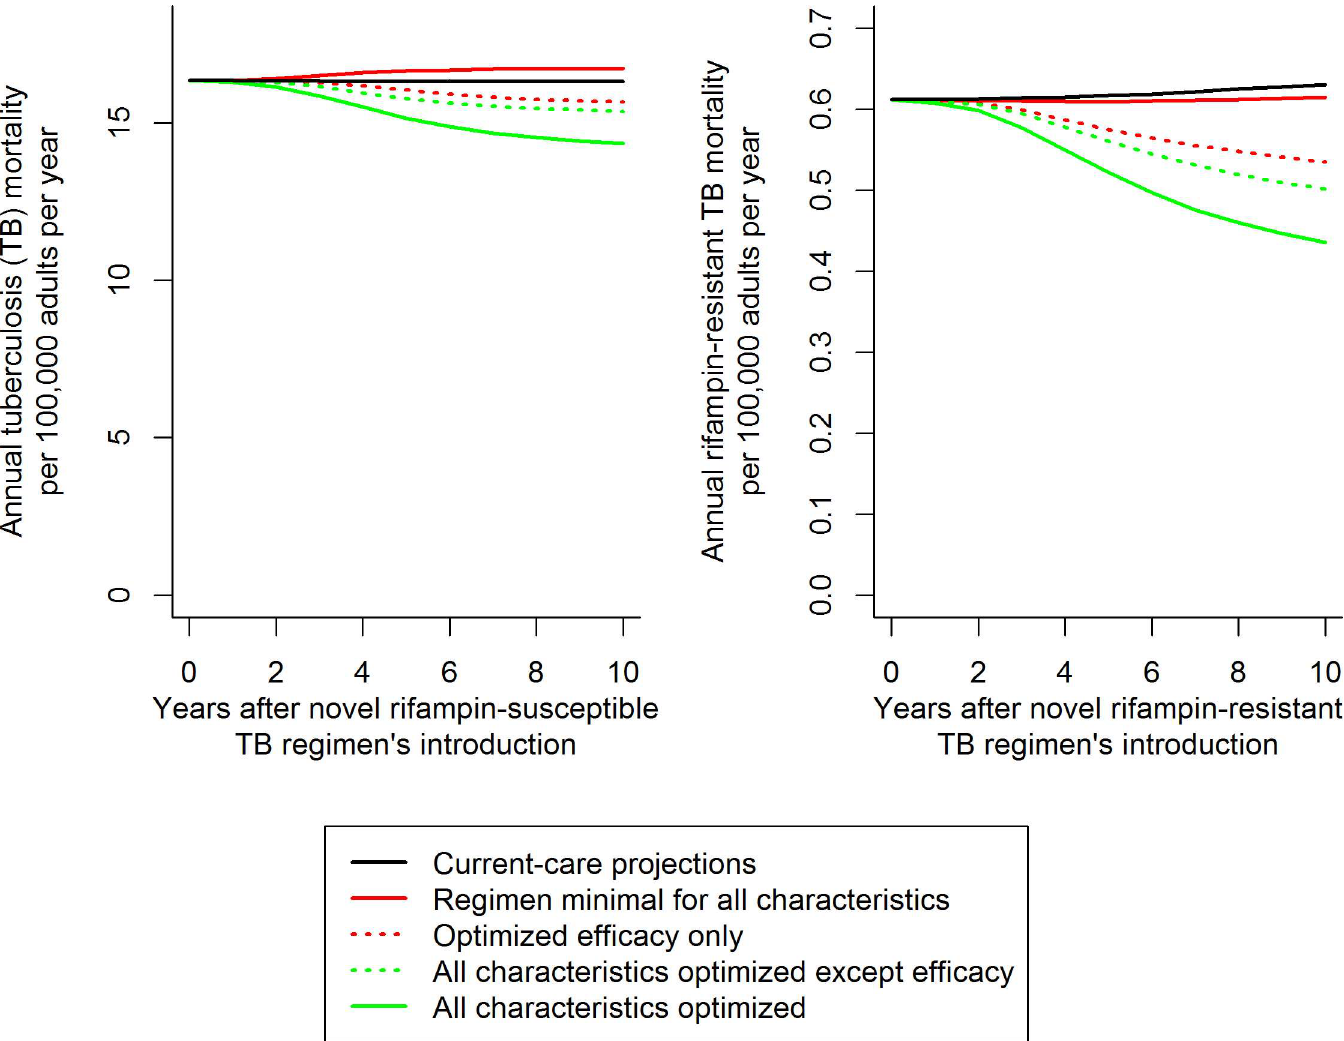
Fig 2. Illustration of resulting mortality trends and comparisons for different novel RS and RR TB regimens. Trajectoriesillustrate the medianimpact of novel regimenson the medianprojectionsof TB mortality. The impact of variationin each individualcharacteristic (such as efficacy, illustratedhere) was evaluatedas a fraction of the total impact of regimen optimization(distancebetweensolid red and green trend lines). This evaluation was performed by optimizingthe characteristic in questionwith an otherwiseminimalbaseline(differencebetweensolid and dashedred lines, corresponding to the results shown in Fig 3A and 3C) and then by removingthe characteristic from an otherwiseoptimizednovel regimen (difference betweensolid and dashedgreen lines, corresponding to Fig 3B and 3D). Scale-up of the novel regimenwas assumed to occur over 3 y followingregimen introduction, and analyseswere performed over the 10 y followingthe novel regimen’sintroduction(includingthe 3 y of scale-up).